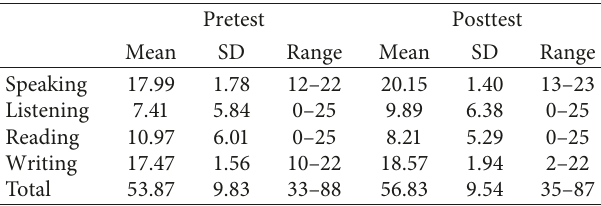
Table 10: Means and standard deviations of the pretest and posttest scores ( N � 324).